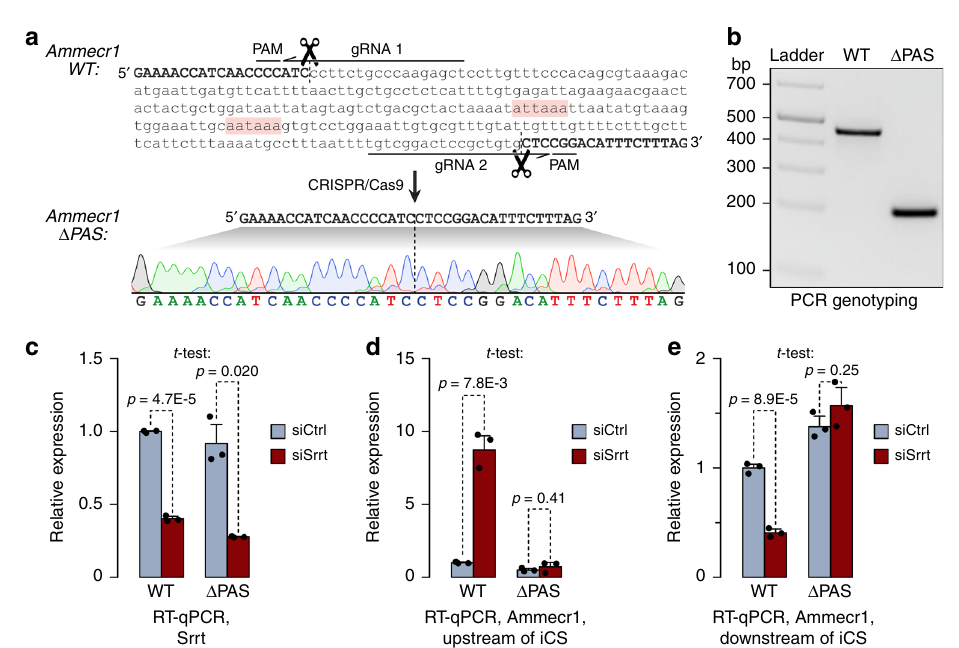
Fig. 3 Intronic cleavage/polyadenylation is required for Ammecr1 regulation by Srrt. a Top: Ammecr1 wild-type (WT) intronic sequence regulated in response to Srrt knockdown. Canonical PAS motifs are highlighted in pink. Also shown are positions of CRISPR gRNAs used to generate the Δ PAS allele. Sequence deleted in Δ PAS is in lowercase. Bottom: Sanger sequence analysis of the Δ PAS Ammecr1 allele. b PCR genotyping result comparing WT and Δ PAS ESCs. c Passage-matched WT and Δ PAS ESC clones were treated with either siSrrt or siCtrl and the ef fi ciency of Srrt knockdown was analyzed by RT-qPCR 48 h later. Note that Srrt levels decrease to a comparable extent in both genetic backgrounds. d , e The effect of siSrrt on the expression of Ammecr1 sequences d upstream and e downstream of the iCS in the WT (and the deleted intronic region in the Δ PAS allele). Note that deletion of the CS region in Δ PAS cells abolishes d siSrrt-induced upregulation of the truncated 5 ′ -proximal transcript and e downregulation of the full-length isoform. Data in c – e were averaged from three experiments ± SD, normalized to the WT/siCtrl samples, and compared by a two-tailed t -test. Source data are provided as a Source Data fi Dicer (Supplementary Fig. 9c). Thus, neither the exosome nor